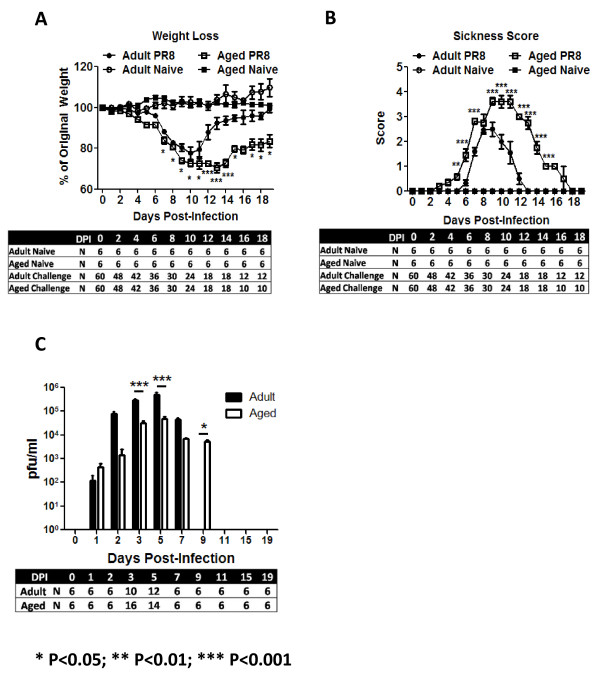
Mouse Morbidity and Lung Virus Titer. Following infection with a sublethal dose of PR8 virus, mice were evaluated daily for weight loss (A) and increase in sickness score (B). Adult mice initial weight was significantly lower than aged animals (21.27 ± 0.2785 vs 24.93 ± 0.5157; P < 0.01). Aged animals (white squares) lost weight quicker, had a higher sickness score and recovered slower than adult mice (black circles). Mock infected animals (white circles -- adults; black squares - aged) did not lost weight or showed signs of disease. Influenza virus titer was evaluated in lung supernatants of adult (black bars) and aged (white bars) mice by plaquing on MDCK cells (C). Aged and adult mice had high virus titer in the lungs. Virus was recovered for a longer period of time in aged animals (C), which correlated with the delayed weight recovery (A) from aged animals and delayed reduction in sickness score (B). This suggested alterations in the immune system of elderly animals. Panels A and B are composites of three different experiments and panel C of 2 experiments. In each graph, the arithmetic mean ± SEM are displayed. The number of animals (N) used to generate each graph is displayed at the bottom of each panel. Stars indicate statistical difference between aged and naïve animals. *P < 0.05. **P < 0.01. ***P < 0.001.